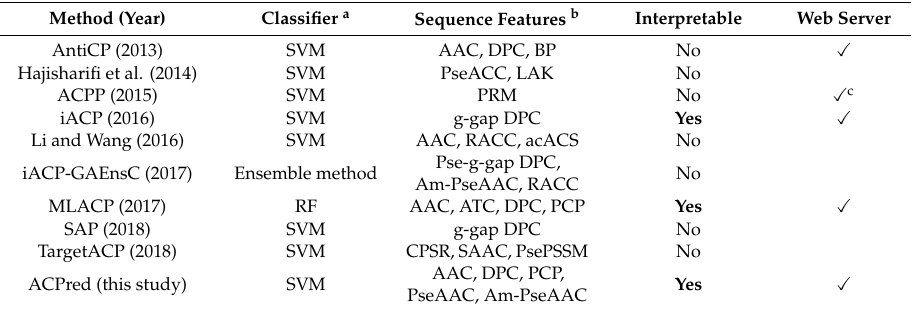
Table 1. Summary of existing methods for predicting anticancer